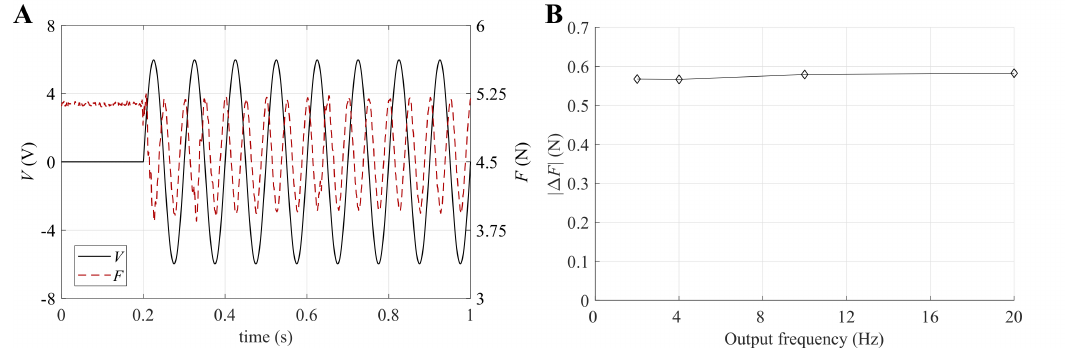
Figure 7. ( A ) Time series of the applied voltage and measured force for a test with excitation frequency of 10 Hz (output frequency of 20 Hz) and ( B ) electrically-induced force variation at different output frequencies for LS-DEA #3 ( λ 2 p = 3) at blocking position x = 100 mm.